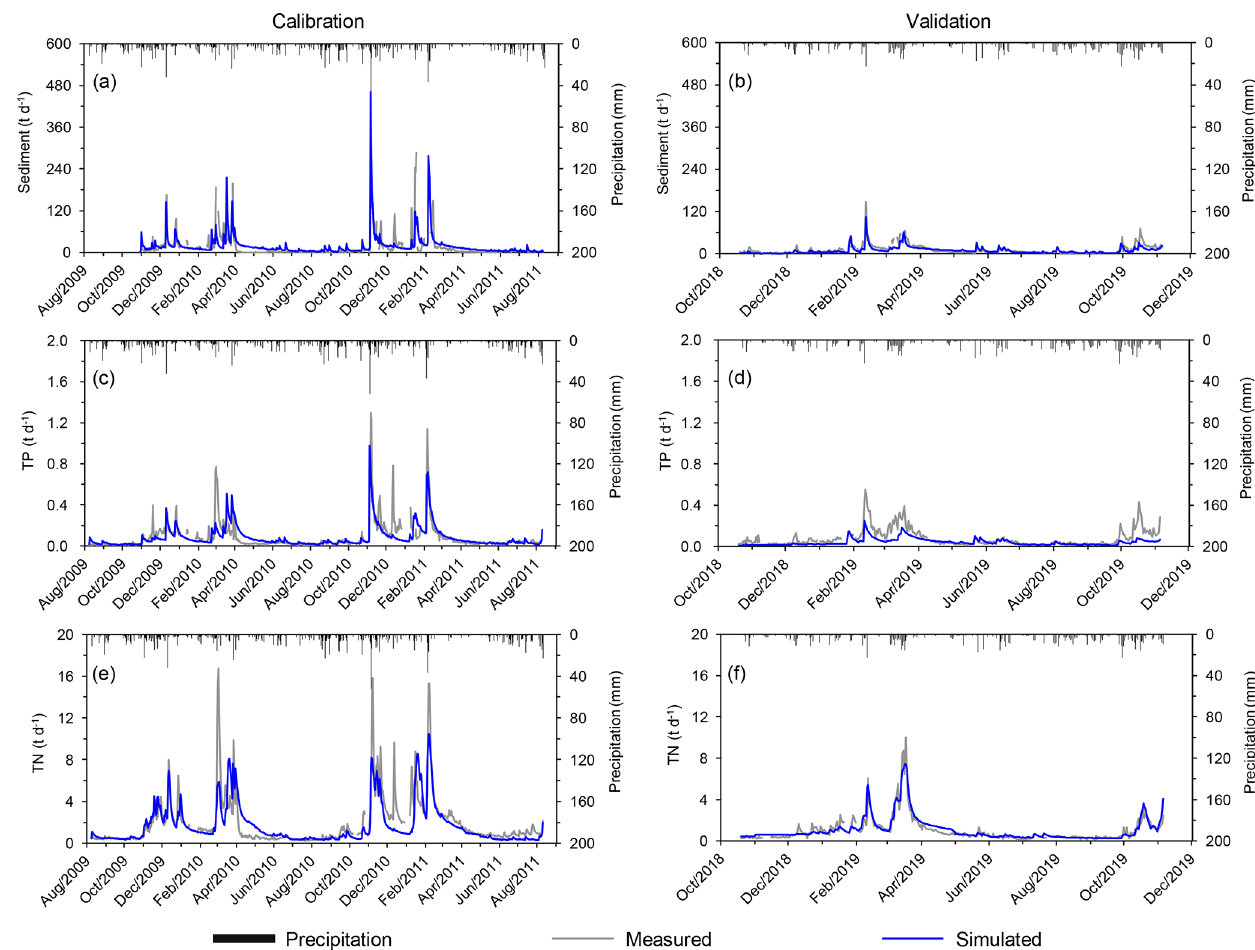
Figure 3. Comparisons between measured and modeled daily loads of sediment, total phosphorus (TP), and total nitrogen (TN), respectively, for calibration (a, c, e) and validation (b, d, f)